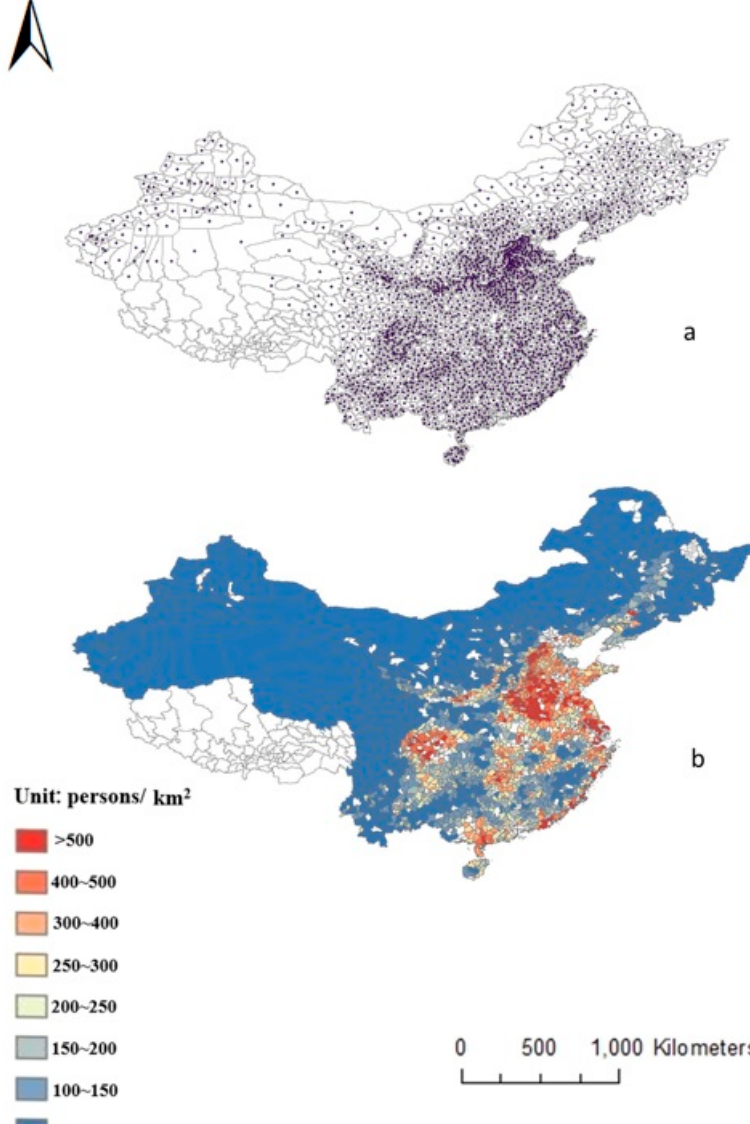
Figure 1. ( a ) County center locations and ( b ) values of observed population data in mainland China at the county level in 2007.